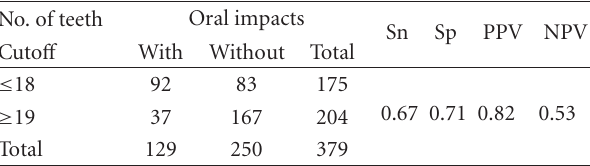
Table 3: Diagnostic performance of 18/19 natural teeth in detecting those with/without oral impacts in ≥ 60 year